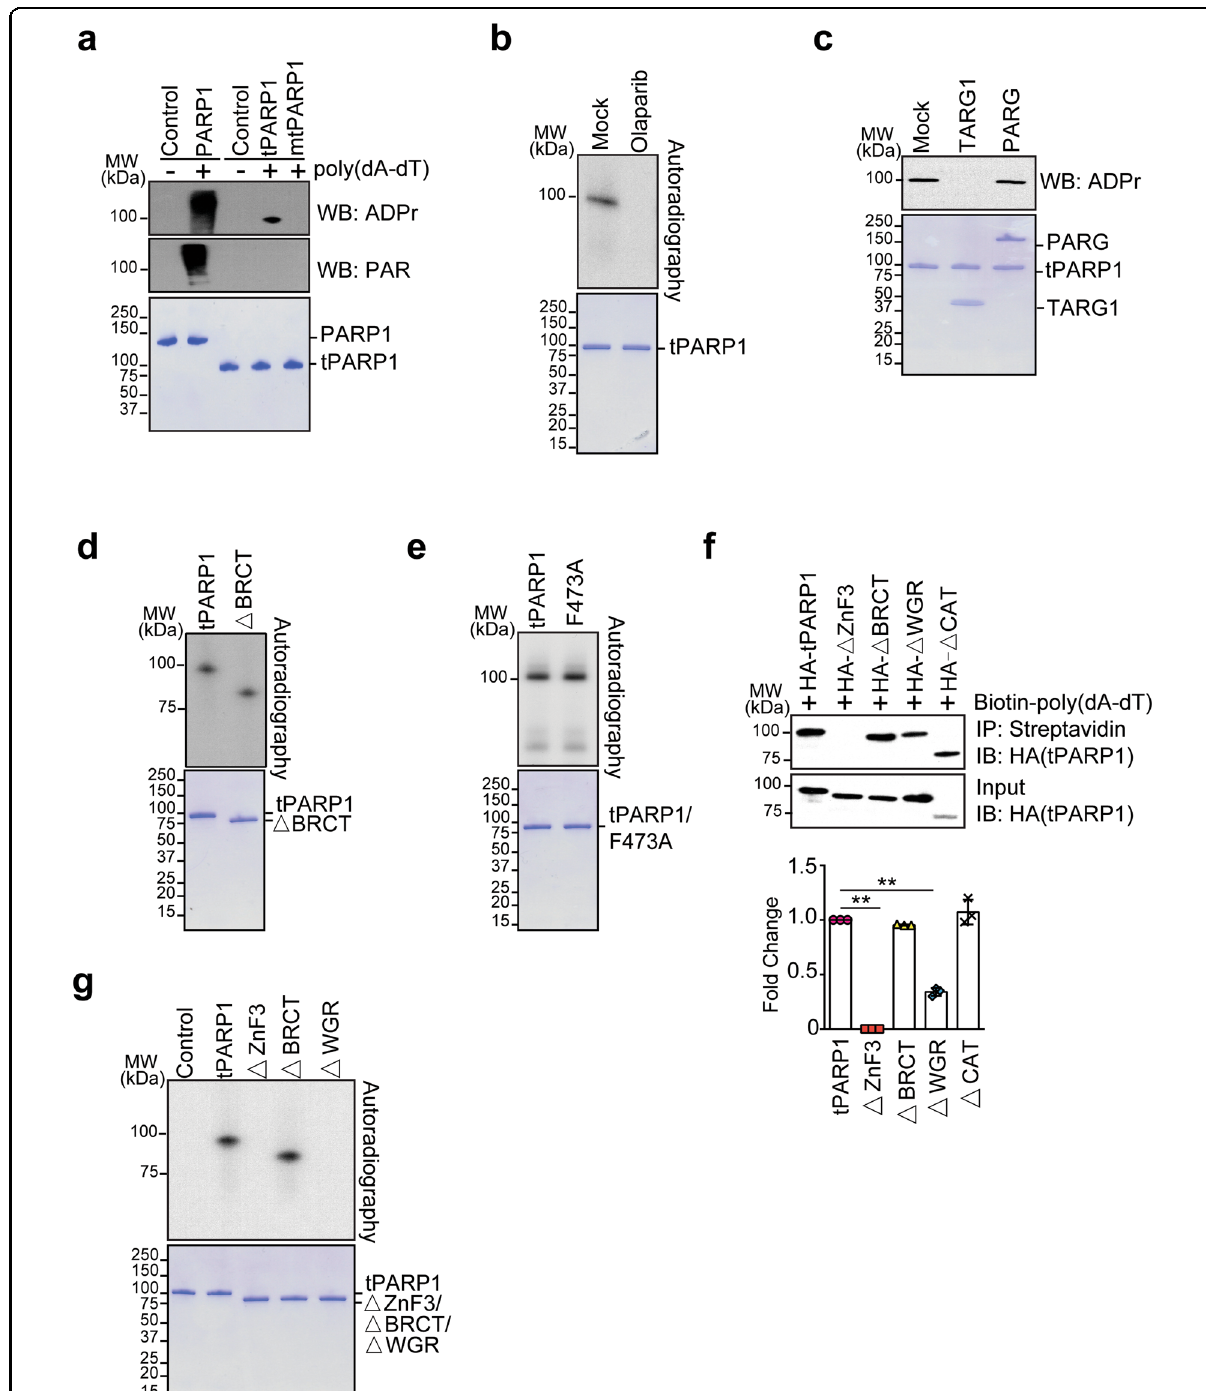
Fig. 4 tPARP1 catalyzes ADP-ribosylation. a In vitro auto-ADP-ribosylation of PARP1 and tPARP1. Recombinant PARP1 or tPARP1 was incubated with NAD + and poly(dA-dT). Auto-ADP-ribosylation was detected by anti-pan ADPr (upper panel) or anti-PAR (middle panel). Recombinant protein in each reaction was also examined by SDS-PAGE and Coomassie blue staining (lower panel). b Olaparib suppresses auto-ADP-ribosylation of tPARP1. c TARG1 but not PARG removes the auto-ADP-ribosylation of tPARP1. d , e The BRCT domain is not required for the auto-ADP-ribosylation of tPARP1. f HA-tagged full length of tPARP1 and four truncation mutants of tPARP1 were expressed in U2OS-PARP1 knockout cells, respectively. The cell lysates were extracted, followed by incubation with 5 ’ biotin-labeled poly(dA-dT). A streptavidin pull-down assay was performed and the complex was detected by western blotting (upper panel). Quantitative analysis of the levels of the pulled down proteins is shown in the lower panel. g The ZnF3 and the WGR domains are required for the auto-ADP-ribosylation of tPARP1. Data are represented as means±SD as indicated from three independent experiments. Signi fi cance of differences was evaluated by Student ’ s t- test. ** P